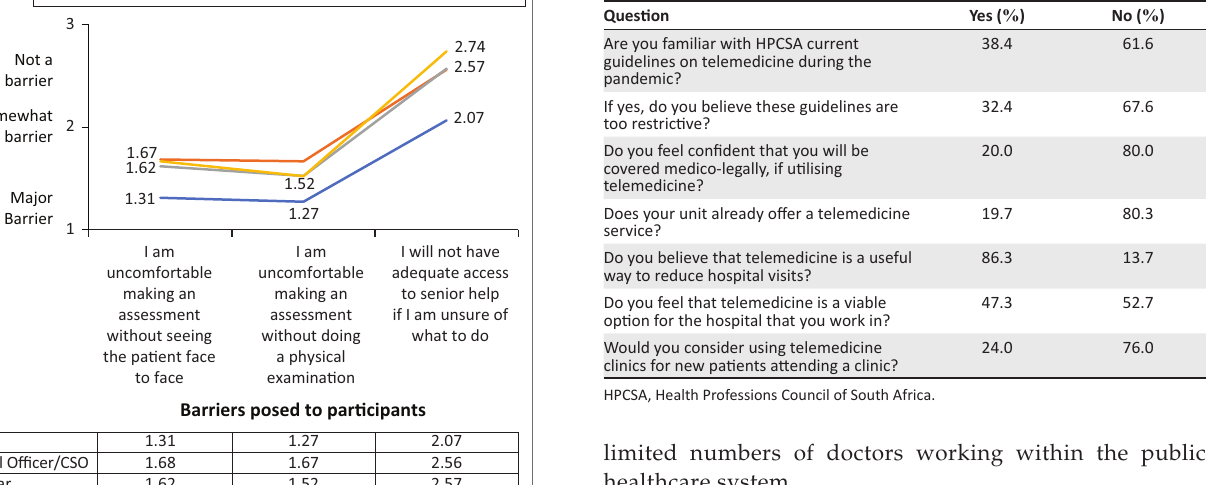
TABLE 2: Responses to other